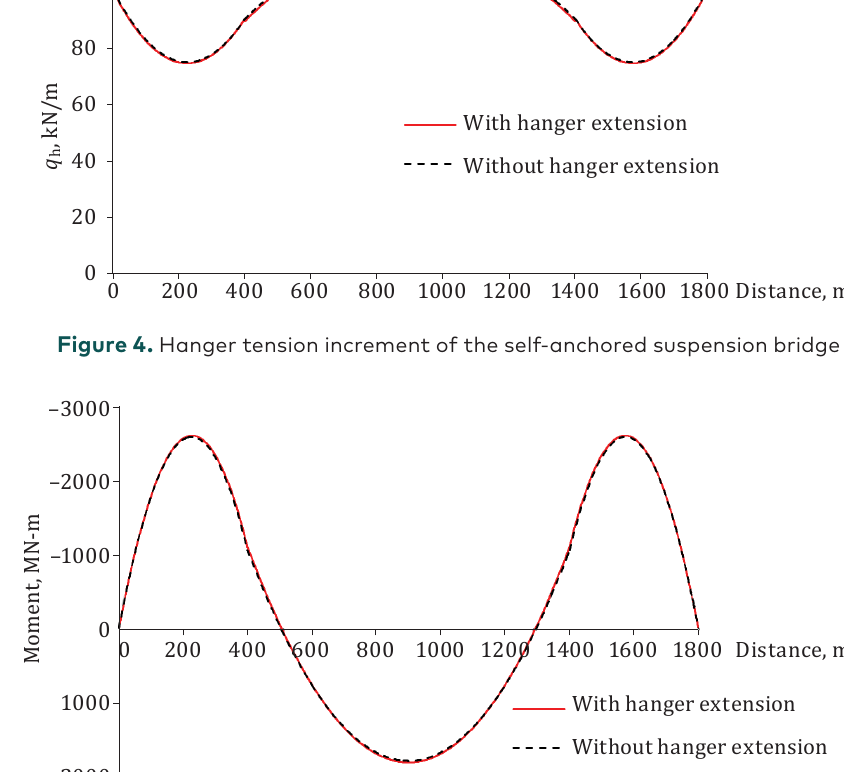
Figure 5. Bending moment of the main girder